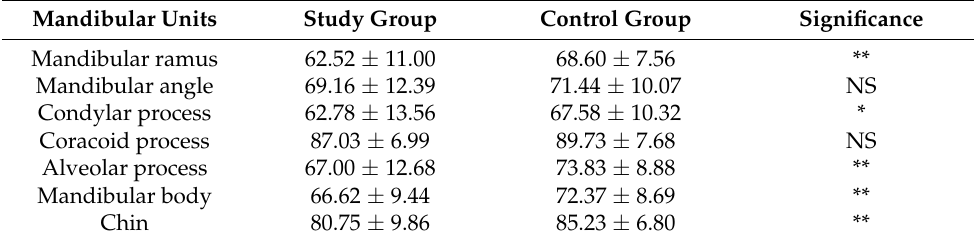
Table 1. Matching percentages of the mandibular functional units.